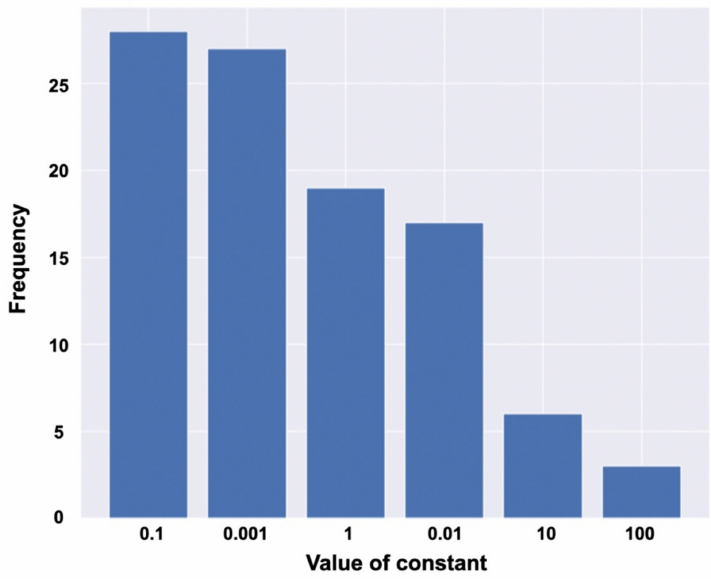
Figure 4. Frequency of each of the constant terms in the parameters.